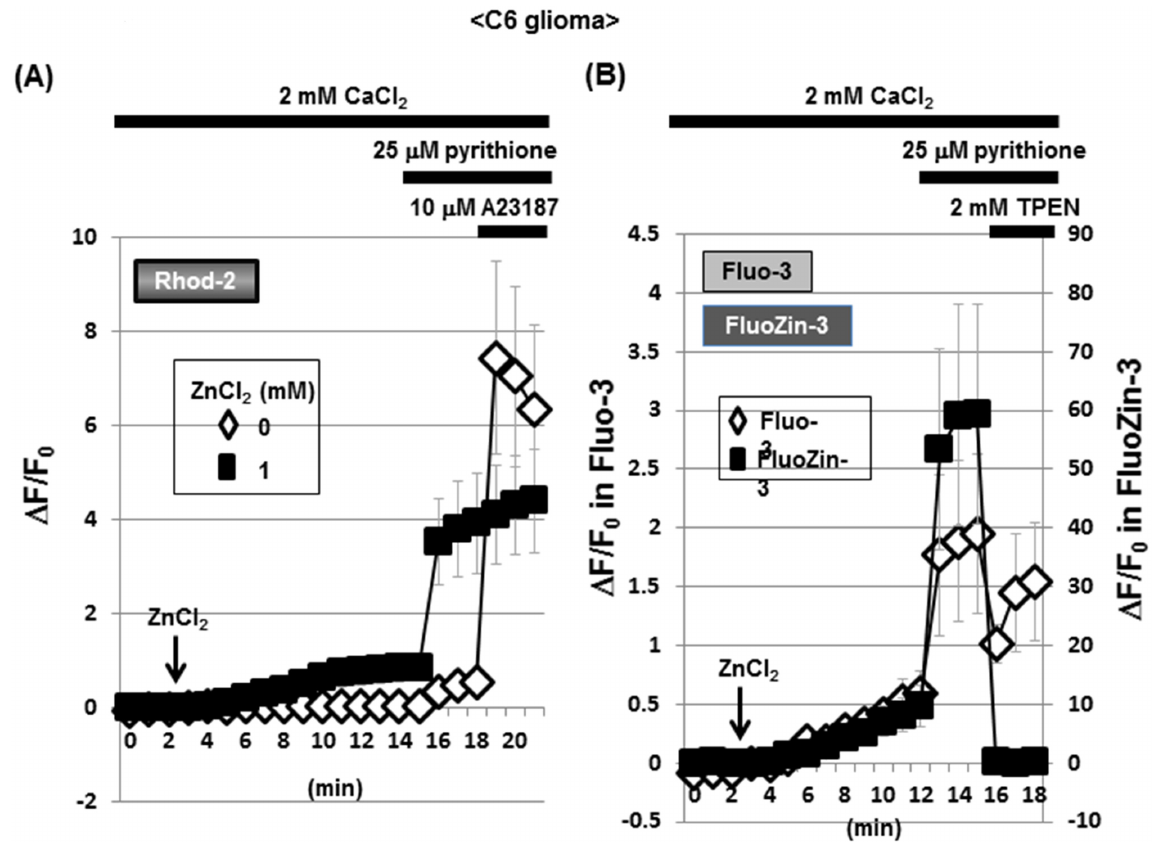
Fig 5. Possible interaction of Ca 2+ -sensitive dyes with Zn 2+ in C6 glioma cells. (A) C6 glioma cells were loaded with Rhod-2 in the presence of CaCl 2 , followed by determination of the fluorescence intensity in either the presence or absence of ZnCl 2 every 1 min. (B) Cells were loaded with either Fluo-3 or FluoZin-3 in the presence of CaCl 2 , followed by determination of the fluorescence intensity in the presence of ZnCl 2 every 1 min. Values are the mean ± S.E. of the rate of fluorescence change in 3 different experiments.